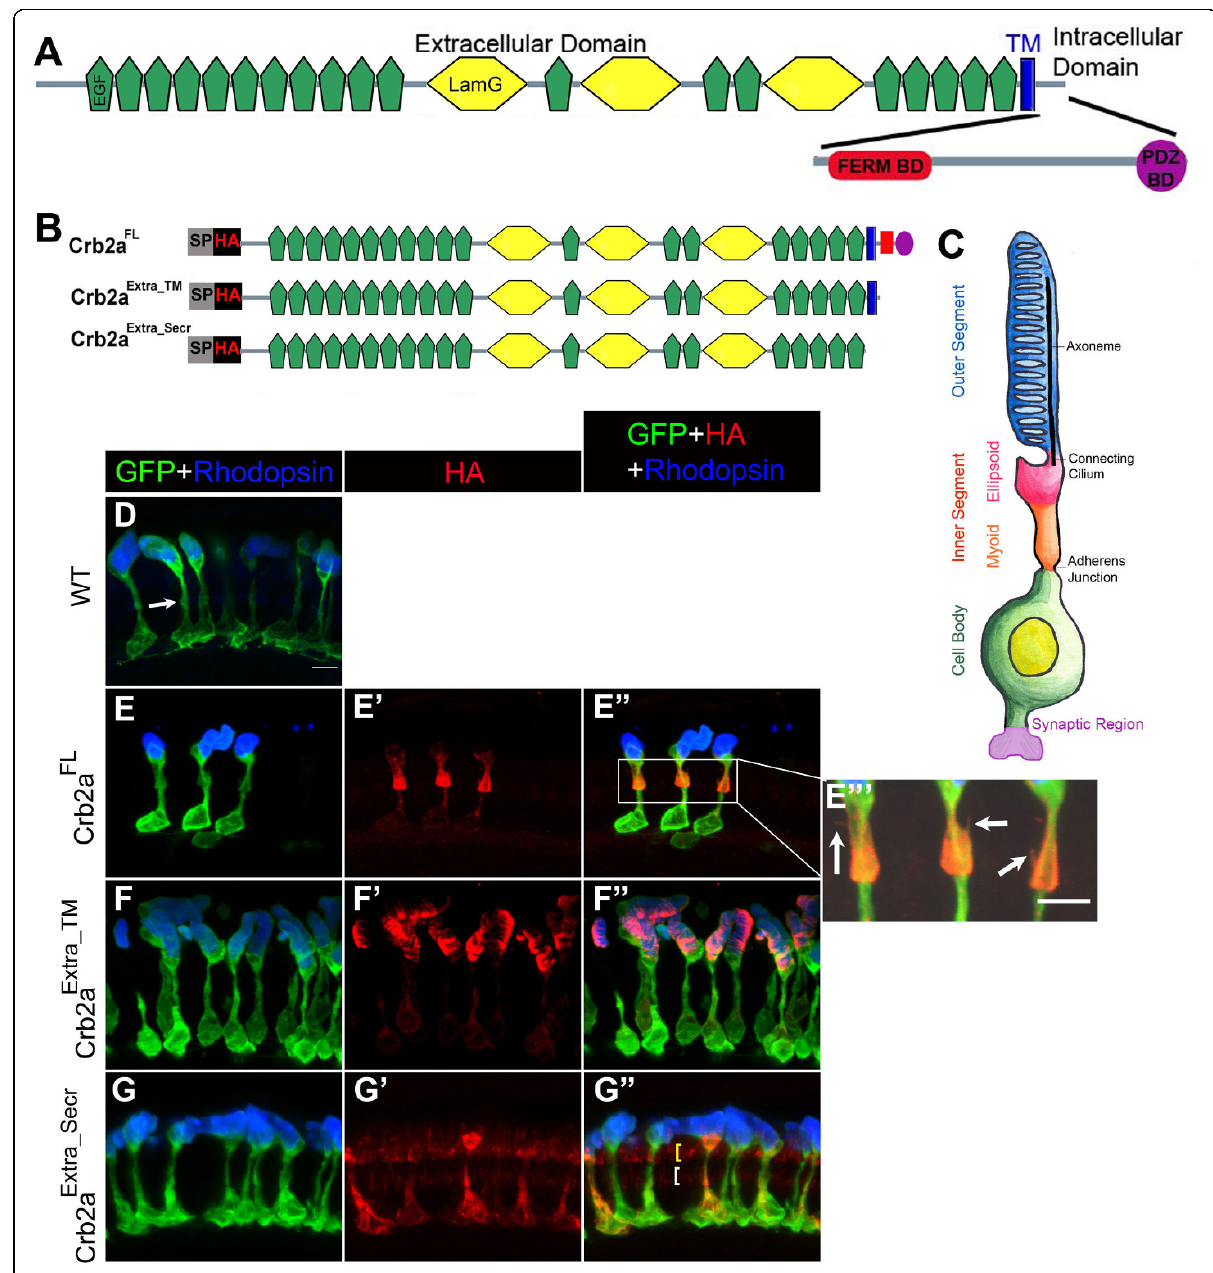
Figure 1 Localization of Crb2a extracellular domain-containing constructs in rod photoreceptors and transgenic rod morphology . Domain structure of zebrafish Crb2a protein. Crb2a is a single-pass transmembrane (blue) protein. The extracellular domain contains 19 EGF-like domains (green) and 3 laminin-like domains (yellow). The small intracellular domain contains two protein-protein interacting domains, the FERM- binding domain (FBD; red) and the PDZ-binding domain (PBD; purple). (B) Crb2a constructs containing the extracellular domain. All constructs have a signal peptide (SP) followed by an HA tag. Crb2a Extra_TM has the same sequence as Crb2a FL except the intracellular domain was deleted. Crb2a Extra_Secr has only the extracellular domain. (C) The rod photoreceptor has four morphologically and functionally distinct compartments: two basal compartments, the cell body (green) and synaptic region (purple), and two apical compartments, the inner segment (orange and pink) and outer segment (blue) filled with membranous discs packed with Rhodopsin. The inner segment is further subdivided into the myoid region (orange) and ellipsoid region (pink). The apical and basal compartments are separated by an adherens junction. (D-G ” ) Confocal z-projections of 6 d rods labeled with GFP (green), Rhodopsin (blue) and anti-HA (red) antibodies. (D) Wild-type rods. The adherens junction, the outer limiting membrane (OLM), is indicated by the white arrow. (E-E ’” ) Crb2a FL transgenic rods. Higher magnification of the inner segment showing fine processes (indicated by arrows) emerging from the inner segment (E" ’ ). (F-F ” ) Crb2a Extra_TM transgenic rods. (G-G ” ) Crb2a Extra_Secr transgenic rods. Two rows of Crb2a Extra_Secr are indicated by yellow and white brackets, Scale bar, 5 μ m (D-G ”